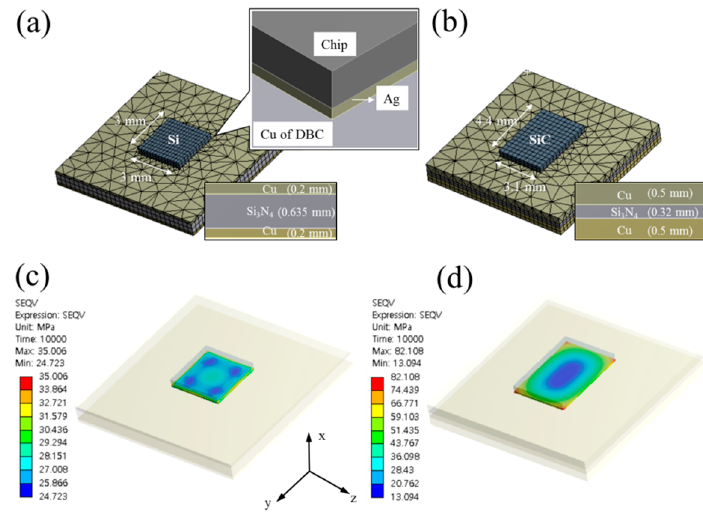
Figure 11. The model of die-attachment structures for finite element simulation: ( a ) previous work [17], ( b ) present work, the stress distribution of model under the change of temperature from 25 °C to 250 °C: ( c ) previous work, ( d ) present work.